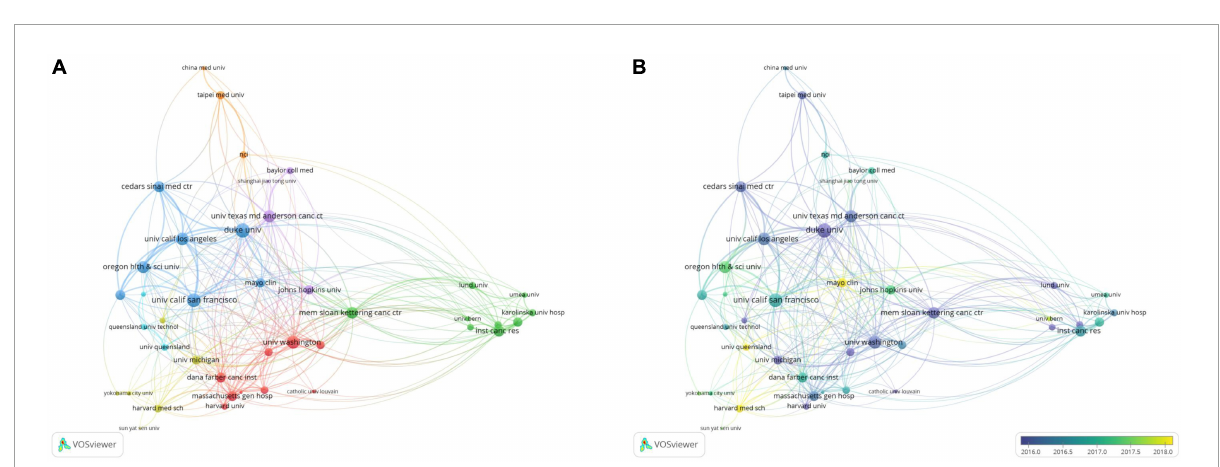
FIGURE5 The bibliometric analysis of the co-authorship of organizations in the field of PCa bone metastasis. (A) The network visualization map of collaborations among organizations in the field of PCa bone metastasis. (B) The overlay visualization map of collaborations among organizations in the field of PCa bone